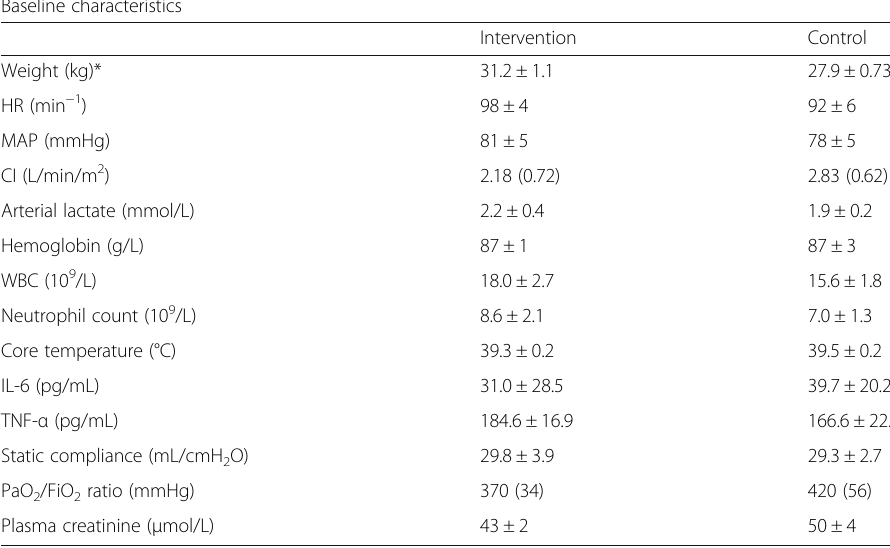
Table 1 Characteristics at baseline Baseline